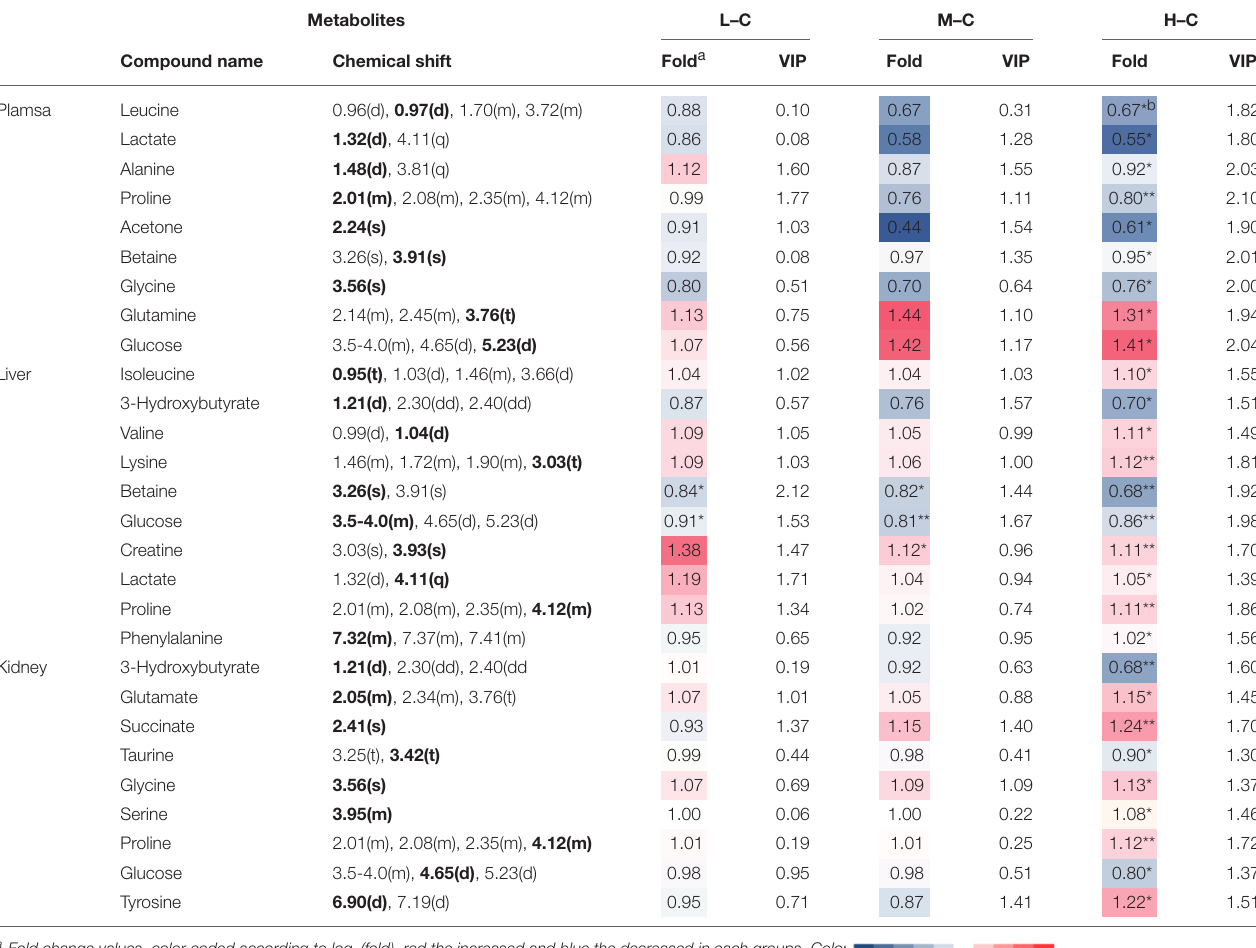
TABLE 2 | Significant change of the metabolites derived from the NMR data from different group at day